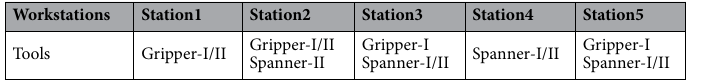
Table 5. Capability of RAL workstations.